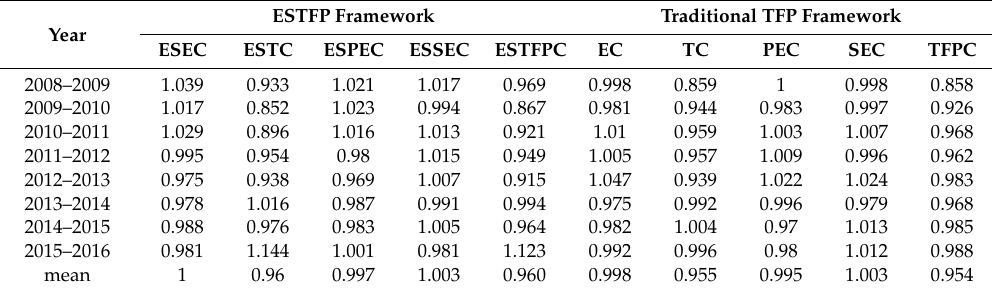
Table 5. Comparison between ESTFP Framework and Traditional TFP